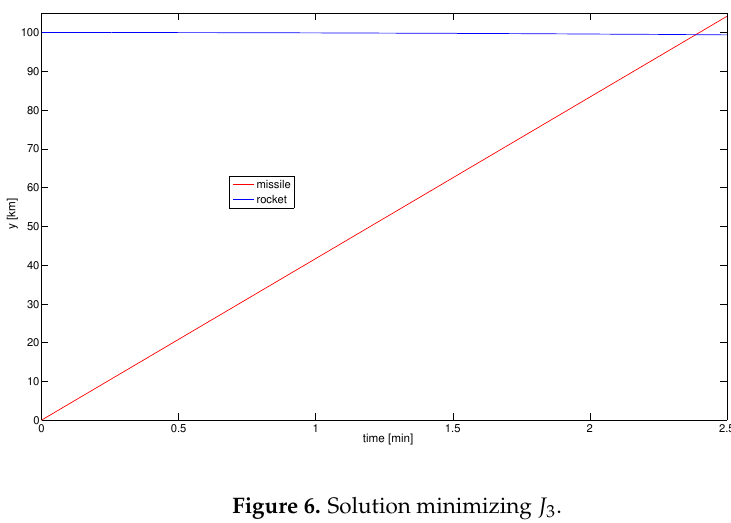
Figure 6. Solution minimizing J 3 .